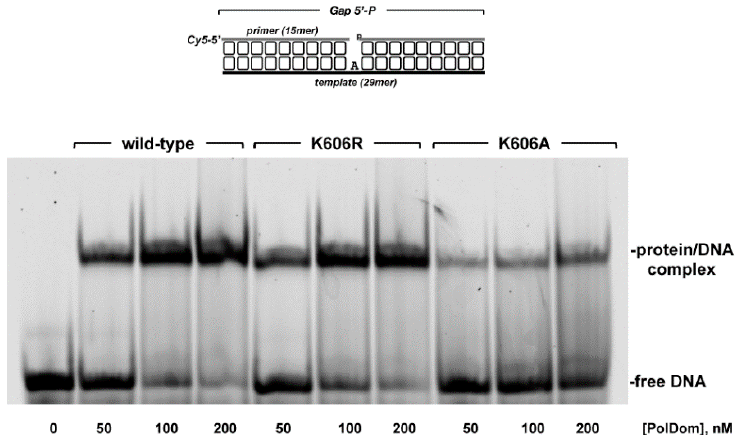
Figure 6. Gel retardation of a primer/template substrate by Pa -PolDom wild-type and mutants K606R and K606A. The assay was carried out as described in Materials and methods, using 50 nM of the depicted primer/template substrate, in the presence of the indicated amount of either wild-type or the indicated Pa -PolDom mutant. After gel electrophoresis, the bands corresponding to free DNA and to PolDom-DNA complexes were visualized using a Typhoon 9410 scanner (GE Healthcare).